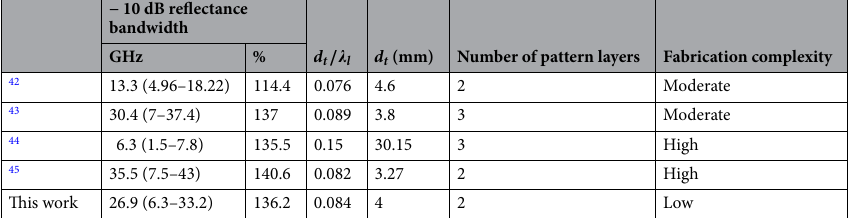
Table 1. Comparisons of simulation results, thicknesses, and fabrication complexities of multilayer electromagnetic